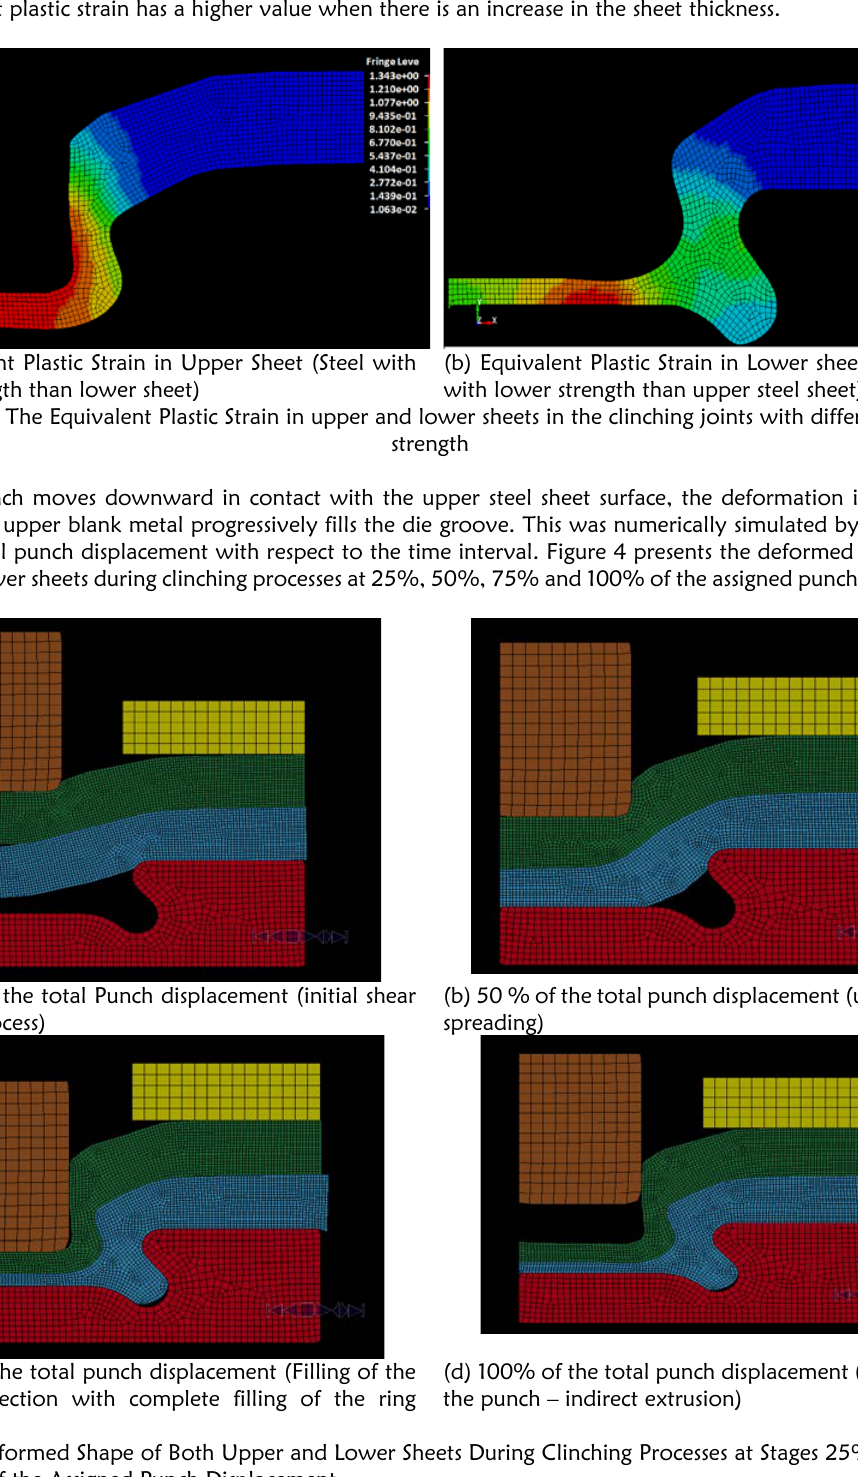
Figure 4: Deformed Shape of Both Upper and Lower Sheets During Clinching Processes at Stages 25%-50%-75% and 100% of the Assigned Punch